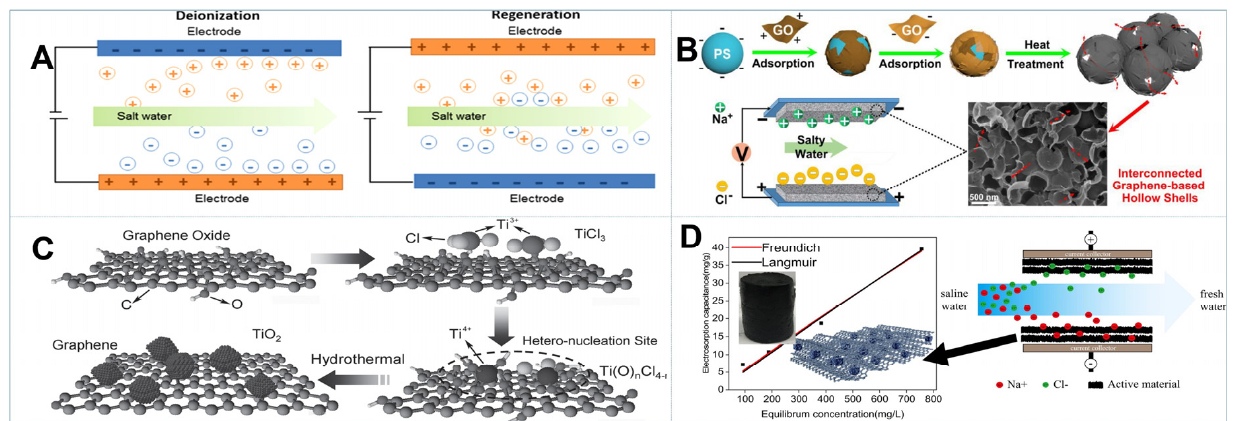
Figure 7. ( A ) Schematic illustration of CDI device [64]. ( B ) Illustration of the preparation of 3D graphene-based hollow shells for CDI applications [65]. ( C ) Formation mechanism of GA/TiO 2 hybrids [175]. ( D ) The adsorption model schematic of MOF/HG composite